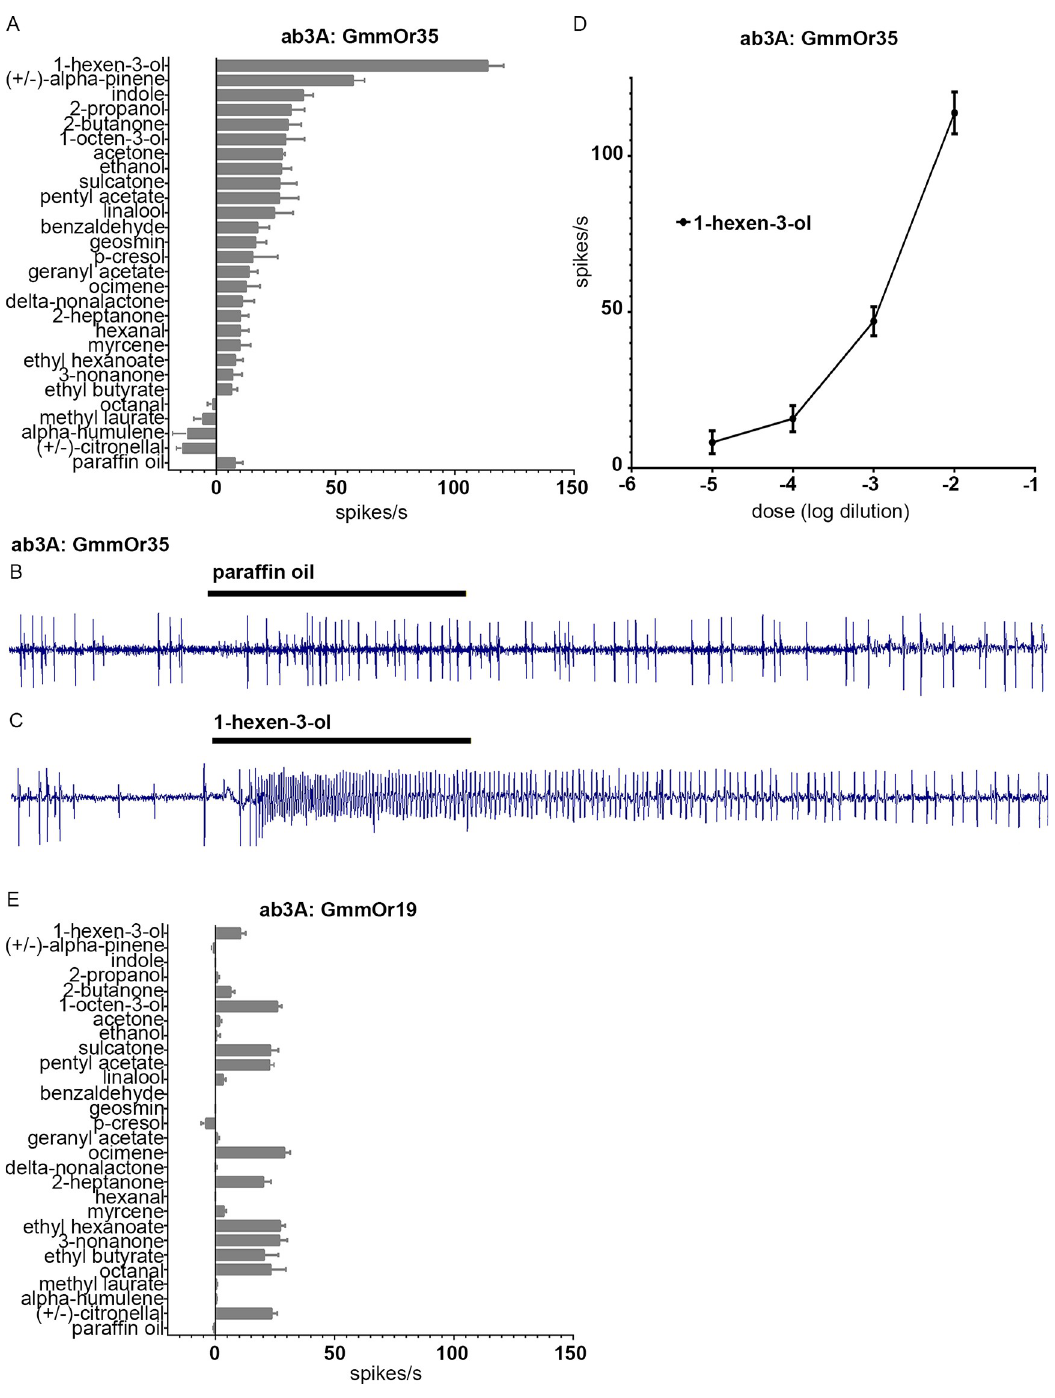
Fig 8. GmmOr35 responds strongly to 1-hexen-3-ol and moderately to alpha-pinene. (A) Odorant response profile of GmmOr35 expressed in homozygous Or22ab GAL4 ab3A ORNs. Neuronal responses are reported in spikes/second +/- S.E.M., to individual odorants diluted 10 − 2 . (B,C) Sample traces from ab3A empty neurons expressing the GmmOr35 transgene in response to the paraffin oil diluent (B) and 1-hexen-3-ol (C), each presented for 0.5 seconds (black bars). (D) Dose response curve for GmmOr35 and 1-hexen-3-ol. (E) Response profile of GmmOr19. In panels A, D, E, spontaneous firing frequencies have been subtracted from all responses; responses to the paraffin oil diluent have been subtracted from the responses to all odorants. n � 5 for all stimuli